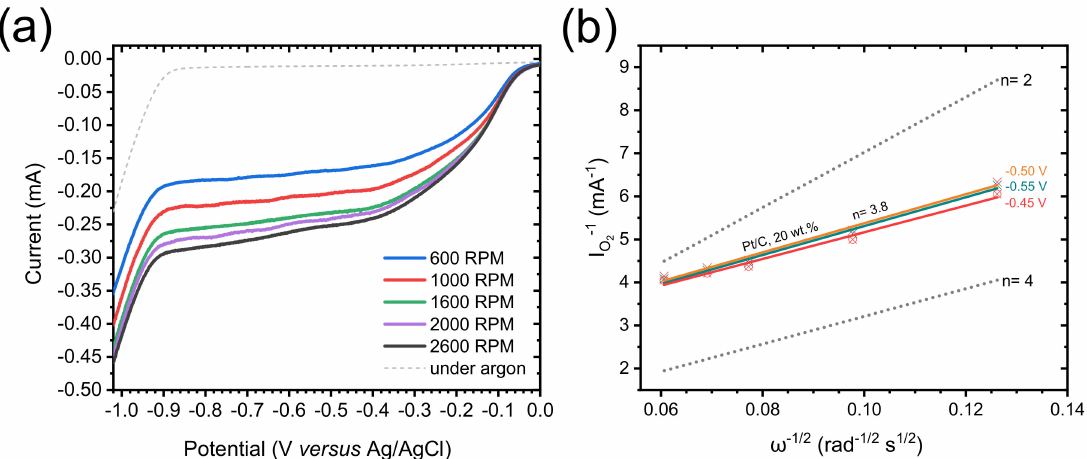
Figure A1. ( a ) Polarization curves measured in O 2 -saturated 0.1 M KOH solution (solid lines) for Pt / C, 20 wt.%, at di ff erent rotation rates from 600 to 2600 rpm, at a scan rate of 10 mV s − 1 . The dashed line is the polarization curve measured in argon-saturated 0.1 M KOH solution, at a scan rate of 10 mV s − 1 and a rotation rate of 1600 rpm. ( b ) Koutecky–Levich plots obtained for Pt / C, 20 wt.% (colored solid lines), at di ff erent voltages (from − 0.45 to − 0.55 V vs. Ag / AgCl). The dotted lines correspond to the ideal two electrons process (n = 2) and four electrons process (n =